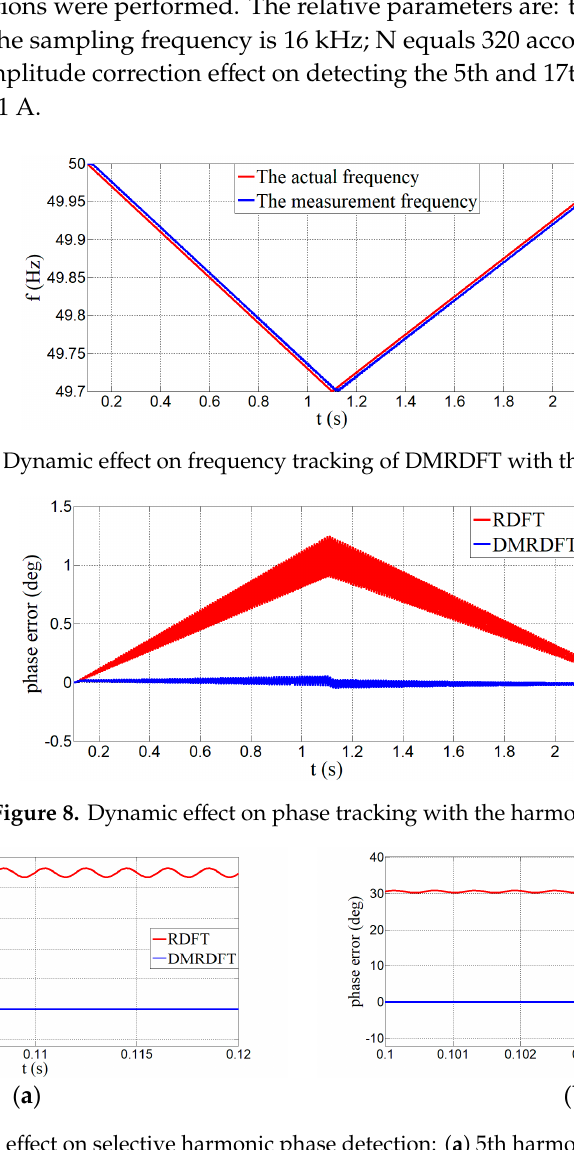
Figure 9. Correction e ff ect on selective harmonic phase detection: ( a ) 5th harmonic ( k = 5), and ( b ) 17th Figure 9. Correction effect on selective harmonic phase detection: ( a ) 5th harmonic ( k = 5), and ( b ) 17th harmonic ( k = harmonic ( k = 17). Figure 9. Correction effect on selective harmonic phase detection: ( a ) 5th harmonic ( k = 5), and ( b ) 17th Figure 9. Correction effect on selective harmonic phase detection: ( a ) 5th harmonic ( k = 5), and ( b ) 17th harmonic ( k = 17). harmonic ( k = 17).